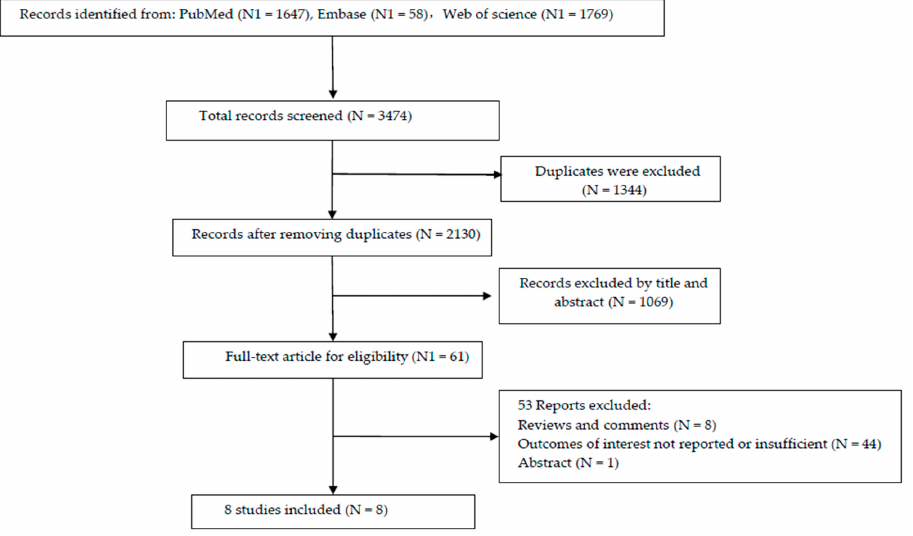
Figure 1. Flow chart of literature search and